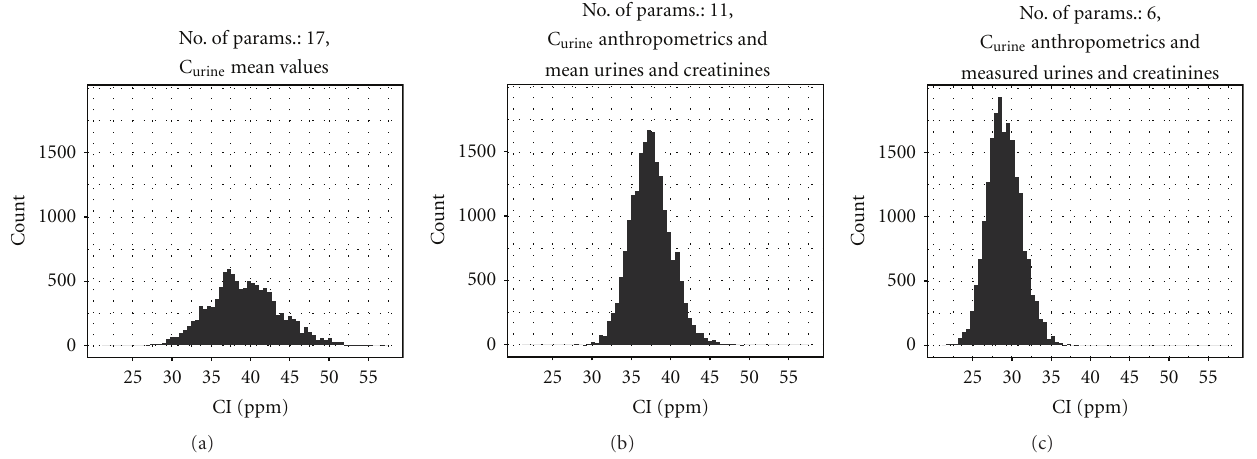
Figure 7: Comparison of estimated posterior distributions for 4-hour inhalation exposure to m -xylene. Posterior distributions were estimated by updating the entire set of parameters, most influential parameters, or by fixing the measured parameters and updating the remaining most influential: (a) C urine , full parameter set, (b) C urine , most influential, (c) C urine , most influential and measured spot urine production rates and creatinine